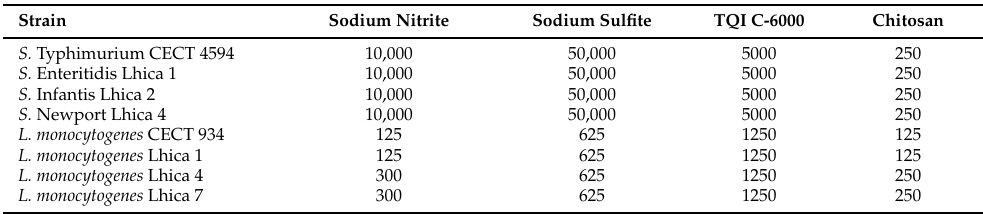
Table 1. Minimum inhibitory concentration (MIC) for each additive tested in Listeria monocytogenes and Salmonella enterica strains used in this study. Results are expressed as